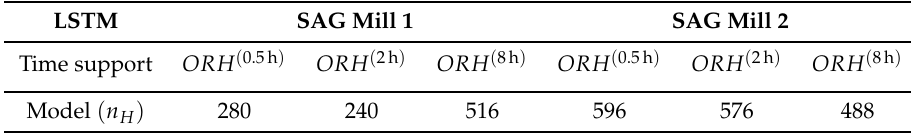
Table 3. Optimal number of hidden units in the LSTM architecture at different time supports [14].